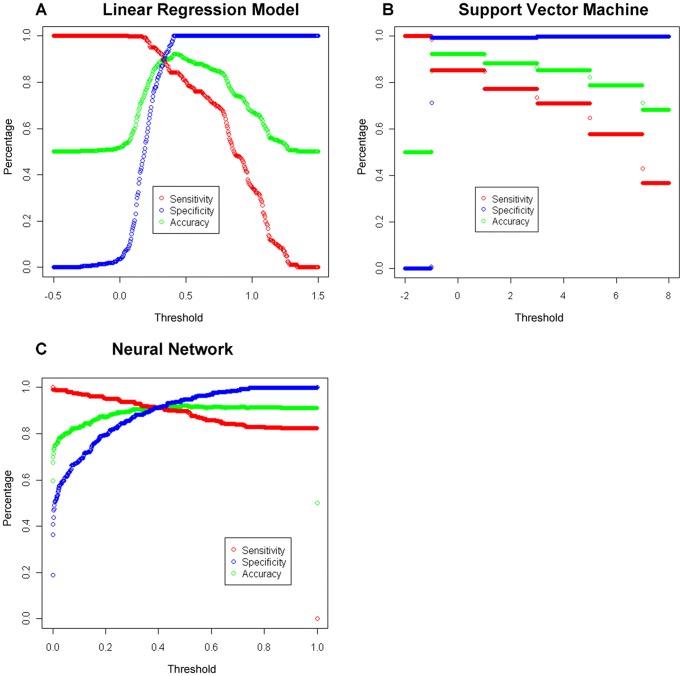
Dependence of minimotif multi-filter performance on threshold values for the linear regression and neural network models.Sensitivity, specificity, and accuracy for the linear regression (A) support vector machine (B) and neural network (C) models. Thresholds were selected by picking the best model in the 5-fold cross validation (model 2 of the linear regression and model 3 of the neural network) evaluated using the test dataset.